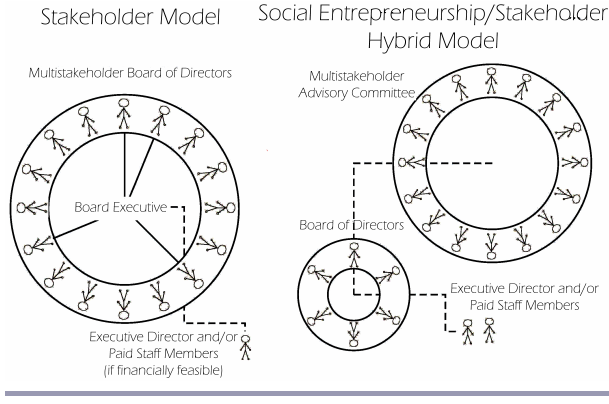
Fig. 2 . Stakeholder model vs. hybrid model in the biosphere reserves explored. Although most biosphere reserves operate using a version of the stakeholder model (a multistakeholder board with selected representatives serving as the board executive and, if financially feasible, one or two staff members), Manicouagan Uapishka Biosphere Reserve uses a hybrid model that incorporates characteristics of both the stakeholder model and the social entrepreneurship model. This allows the organization to have diverse representation through their advisory committee, while having an engaged and active board with the knowledge and skills necessary to work with staff members to move the organization